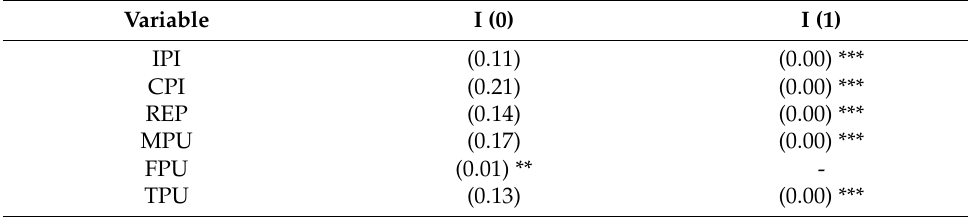
Table 2. ADF Test.